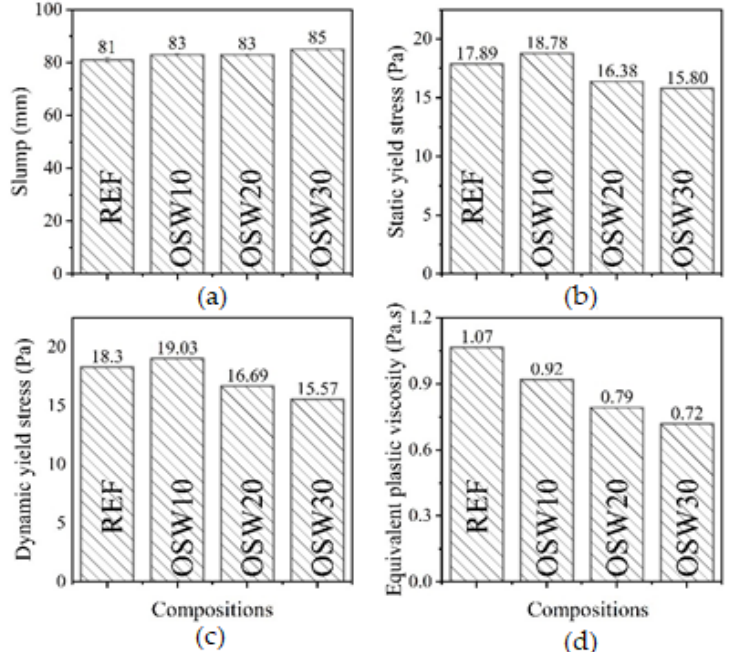
Figure 7. Rheological properties of the pastes. ( a ) Slump; ( b ) static yield stress; ( c ) dynamic yield stress; ( d ) equivalent plastic viscosity.